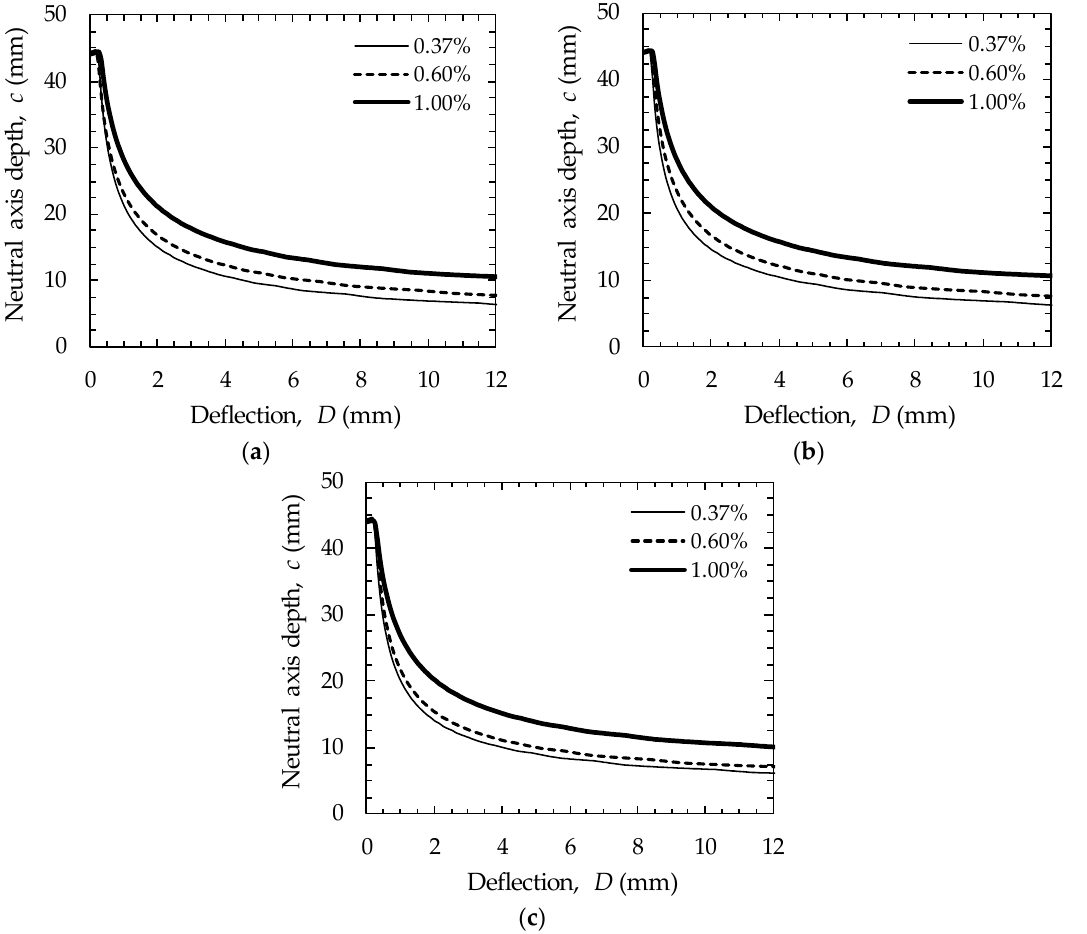
Figure 14. Calculated neutral axis depth and deflection relationships: ( a ) 3D fiber, ( b ) 4D fiber, ( c ) 5D fiber.